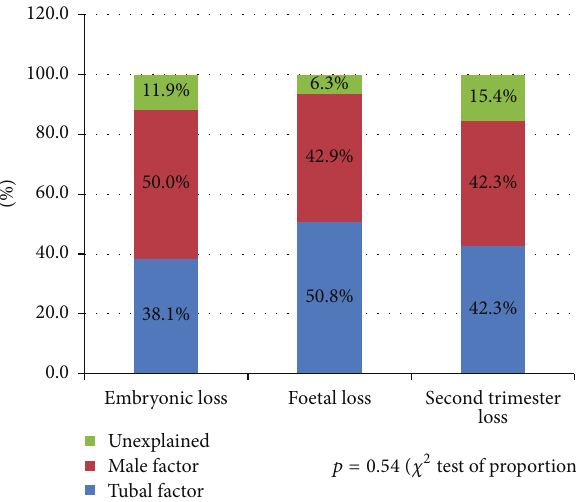
Figure 4: A comparison of the pattern of miscarriage in tubal, male, and unexplained